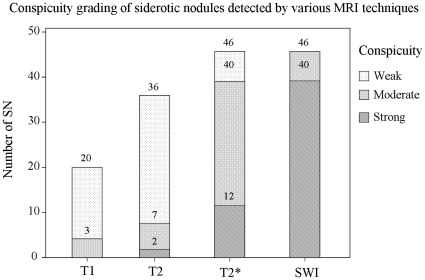
Conspicuity grading of siderotic nodules by various magnetic resonance imaging techniques.Results indicate the mean number (vertical axis, for both readers) of siderotic nodules (SN) and the relative conspicuity grade.